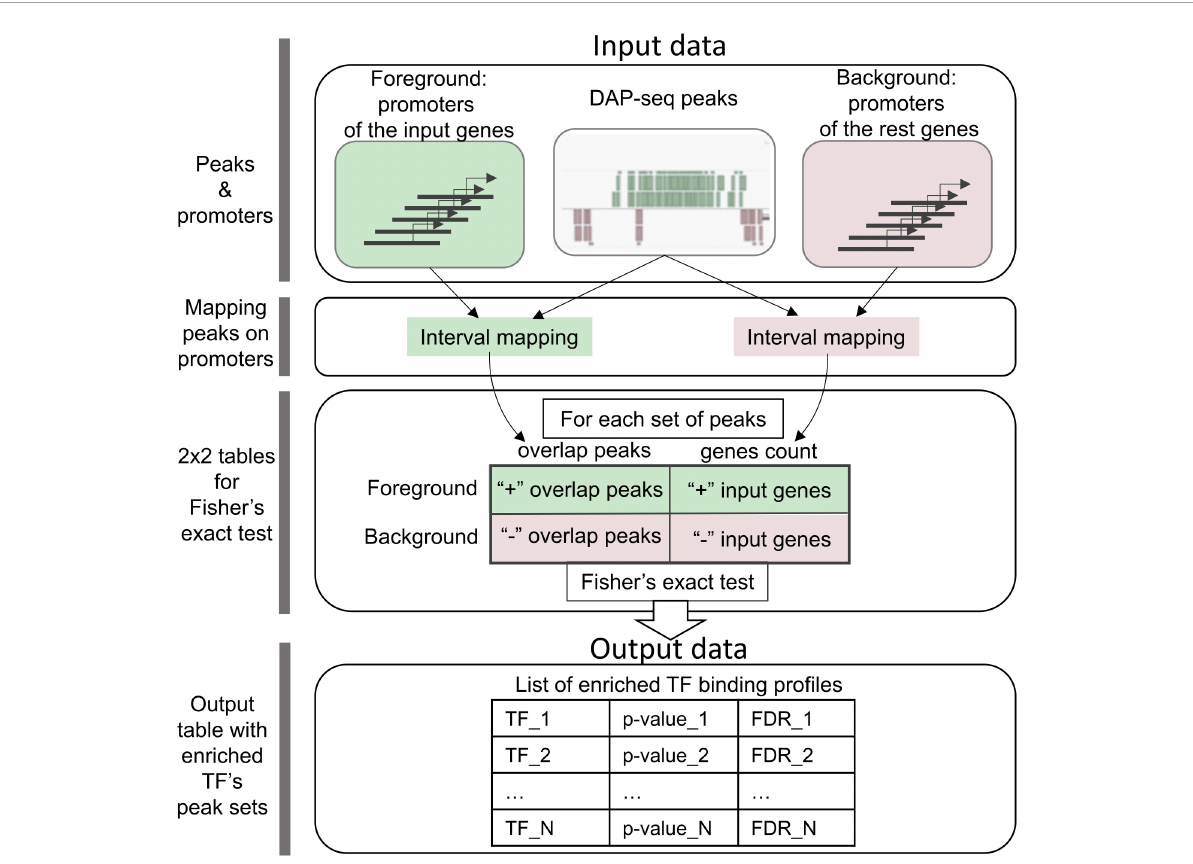
FIGURE1 CisCross algorithm scheme (see section “Materials and methods”). Green/pink colors mark foreground and background data and respective parallel processes of their analysis. Foreground and background data comprise the annotations of promoter regions of the input genes and the rest genes, respectively. For one DAP-seq set of peaks, the first step of the analysis maps the peaks to promoters of the input genes and the rest genes. The second step uses these data of genome mapping to compile a 2 × 2 contingency table for the input genes and the rest genes with the counts of genes whose promoters overlap or do not overlap the peaks. Finally, Fisher’s exact test is applied to estimate the enrichment of the peaks in promoters ( p -value). Output data comprise the list of enriched TF binding profiles in the ascending order of FDR (the significance p -value adjusted for multiple